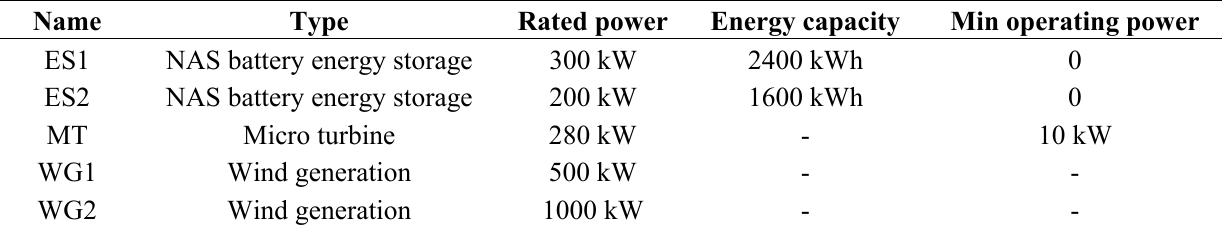
Table 1. Electrical specifications of the